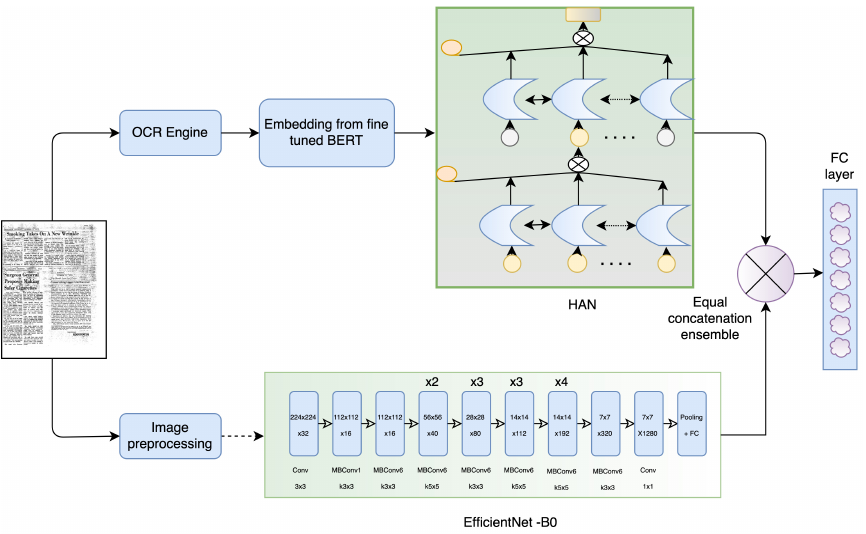
Figure 2. The figure depicts the overall architecture of the network. As we can see, the document image is split into two streams. The textual stream consists of an OCR engine, fine-tuned BERT, and the HAN model in series. The visual stream is composed of a preprocessing layer and an EfficientNet model. The features from both streams are then assembled with equal concatenation and finally passed on to the fully connected layers with softmax to classify against ten classes of the Tobacco-3482